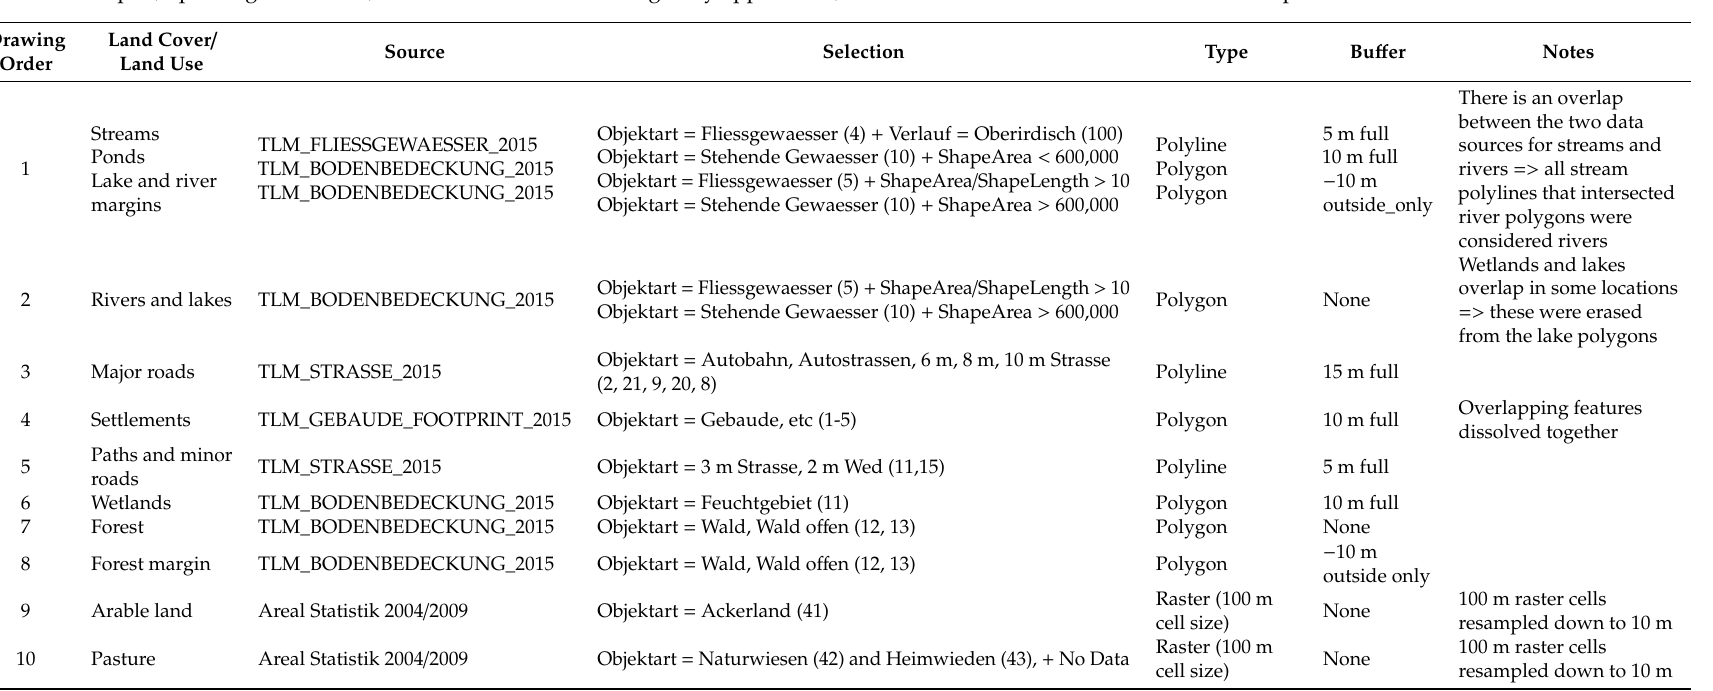
Table A1. m (one cell width) except for fine-scale linear features like streams and paths (5m), or the low drawing order / low resolution land use categories (none). Major roads were bu ff ered by 15 m to ensure that they were always drawn at least two cells wide and acted as strong barriers (current jumps easily across the curves of linear single cell barriers in raster datasets because barrier cells are only connected at the corners instead of their sides). Any cell within the map lacking classification after filling the model with all other categories was assigned to ‘Pasture’. This was done under the assumption that most of these cells would be marginal, undeveloped, open vegetated land, such as the areas around highway approaches, which would have similar characteristics to